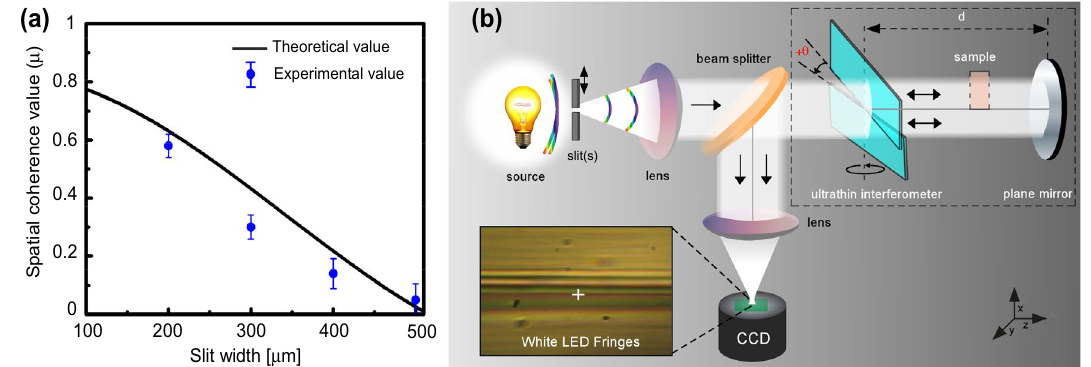
Figure 5. ( a ) Effect of slit width (s) on spatial coherence value ( µ ) or visibility (V) of fringes of white LED source. Theoretical curve corresponds to A 440 nm, L = 32 cm and A = 0.83. ( b ) Schematic of double pass ultrathin interferometer. Inset: white LED interference fringes are